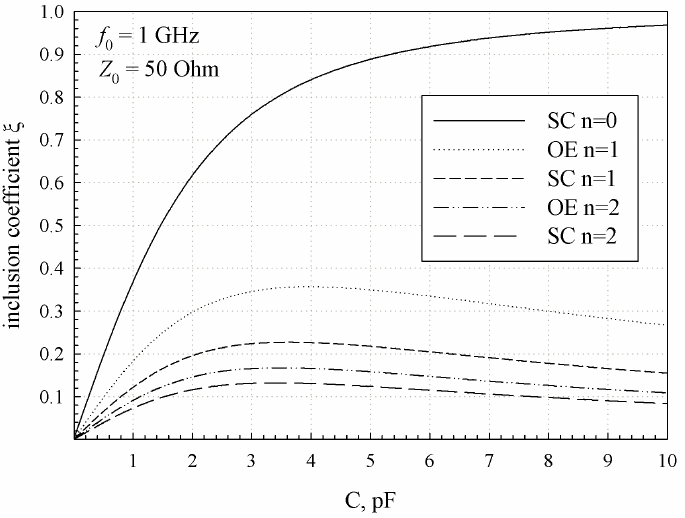
Figure 1. The dependence of the inclusion coefficient on capacitance